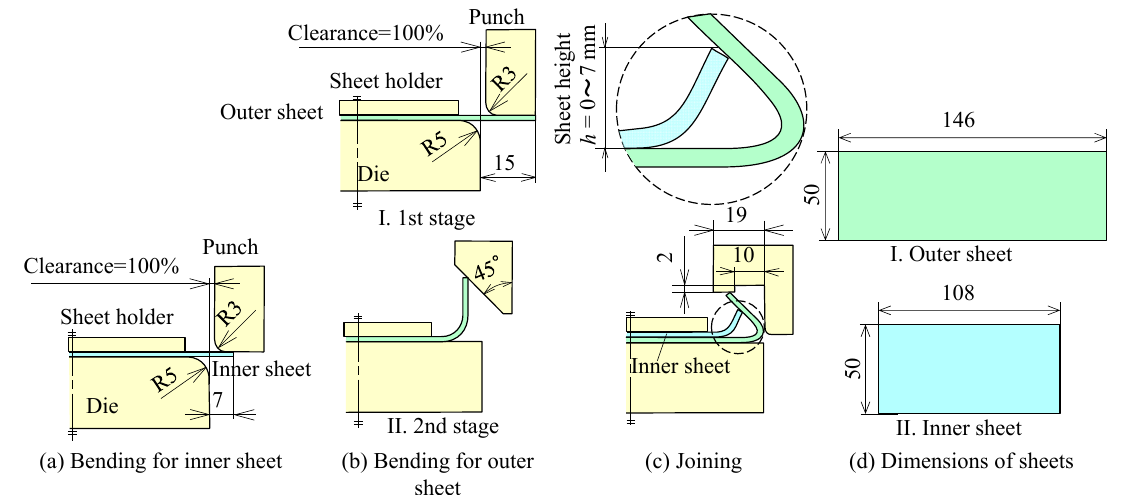
Figure 2. Joining conditions of sheets by hemming with pre-bent inner sheet.